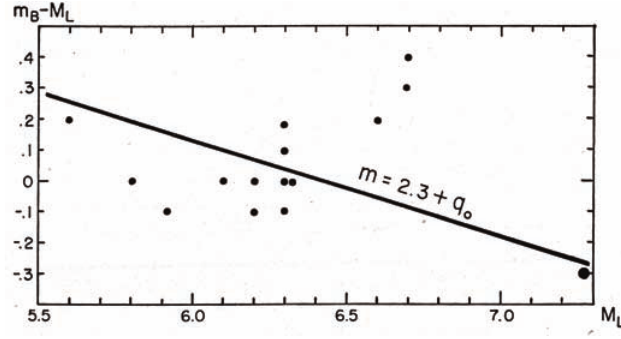
Figure 7. Combining equations (9) and (11), m = 1.7 + 0.8 M